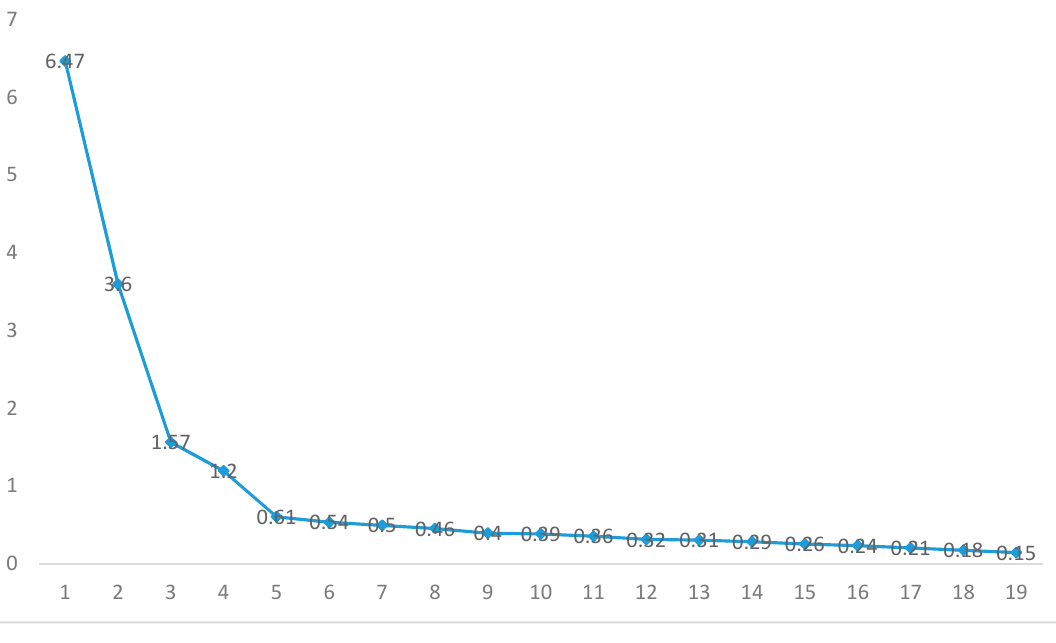
Figure 2. Scree plot for the factor analysis of the scale, following the proposed theoretical model.